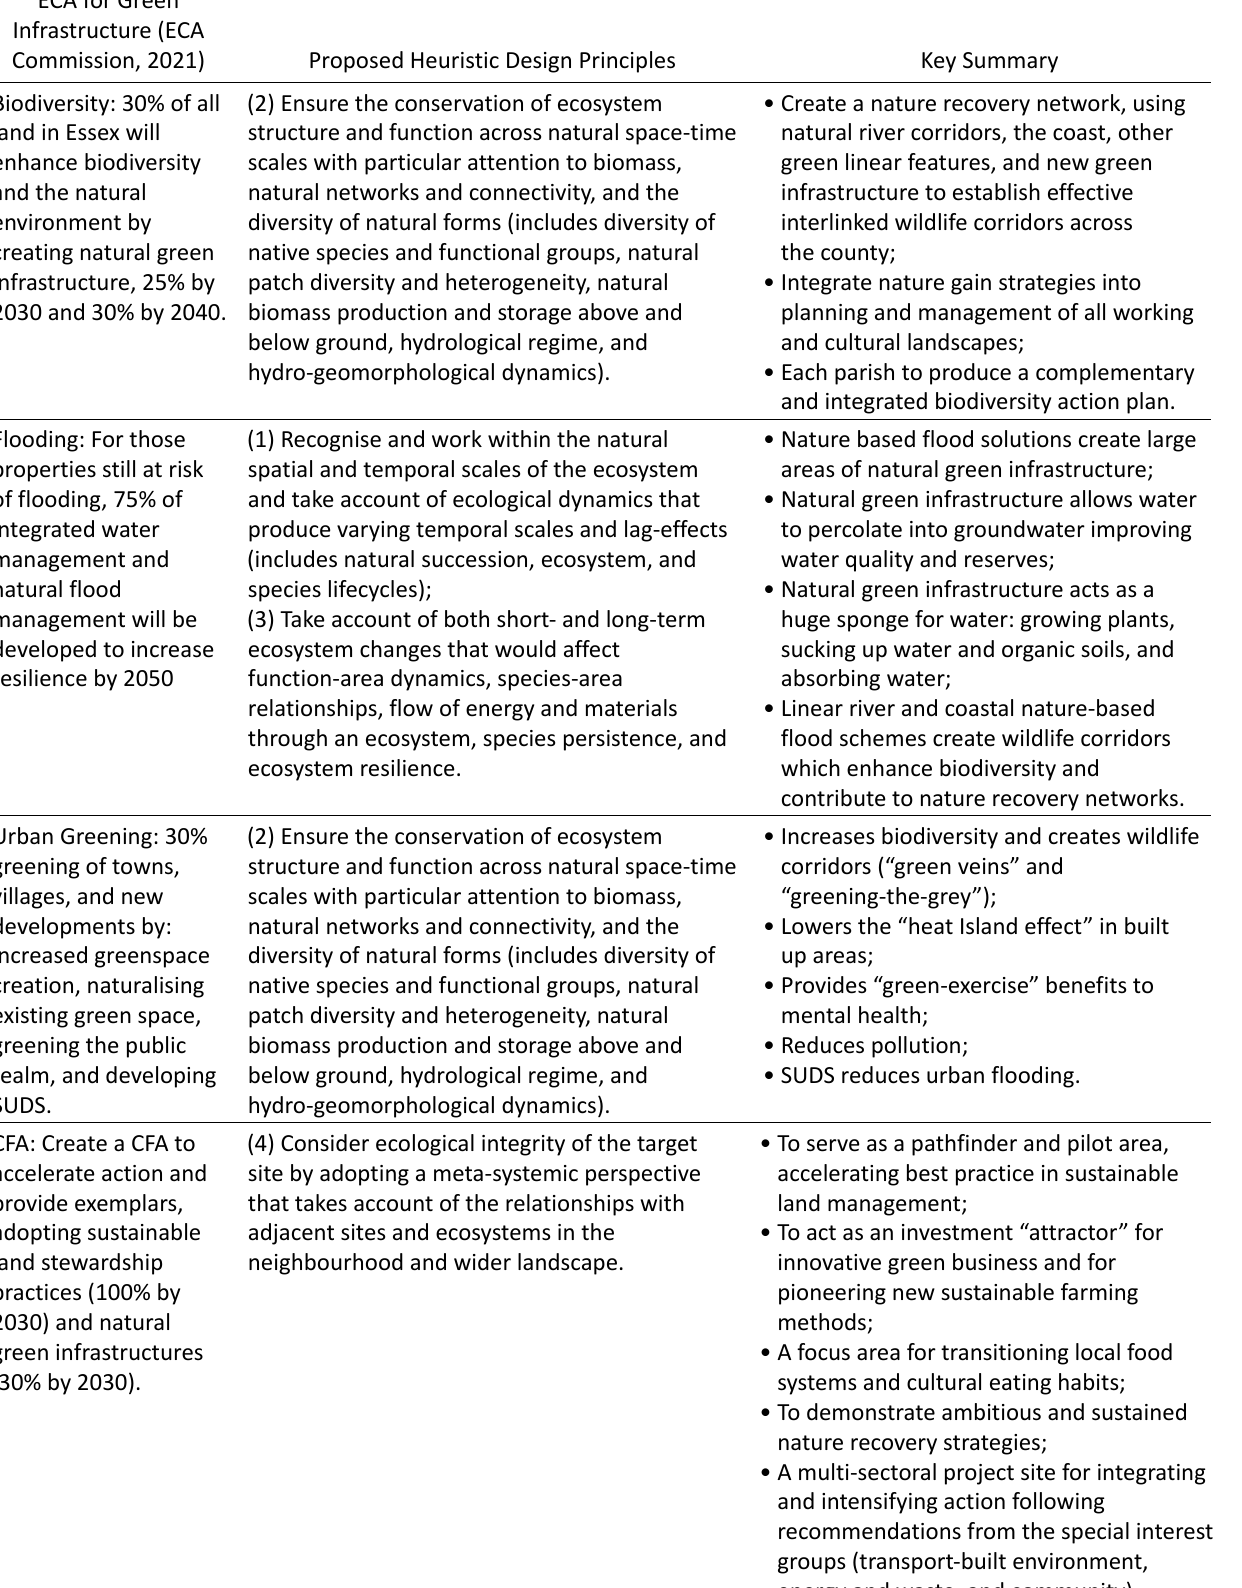
Table 1. (Cont.) ECA and heuristic design principle evaluation chart. This table shows the evaluation of ECA recommenda‐ tions through theoretical application of proposed heuristic design principles to the ECA recommendations. The key sum‐ mary demonstrates proposed action points for the ECA recommendations with an enhanced approach to ecosystem‐led planning and